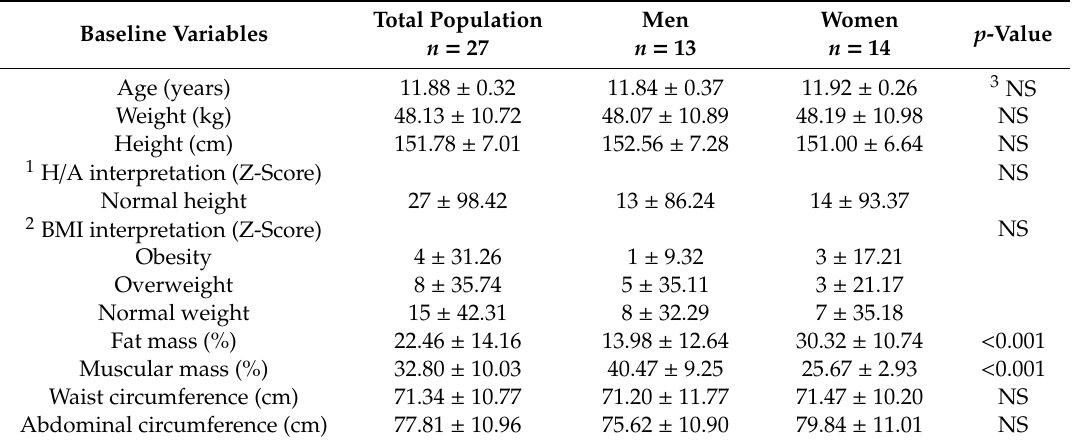
Table 2. General characteristics for men, women, and total participants included in the supplementation